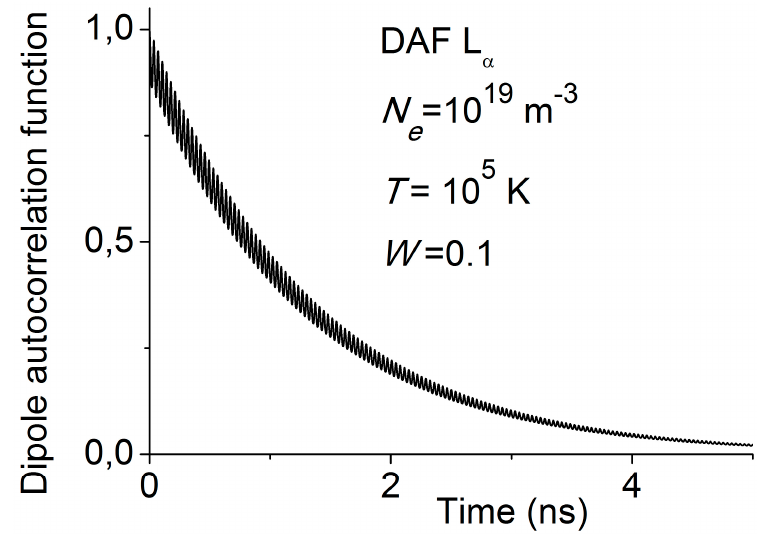
Figure 3. L α dipole autocorrelation function in a plasma with a density N e = 10 19 m − 3 , and a temperature T = 10 5 K, calculated with a product of the impact DAF and the Langmuir rogue wave DAF for W = 0.1.